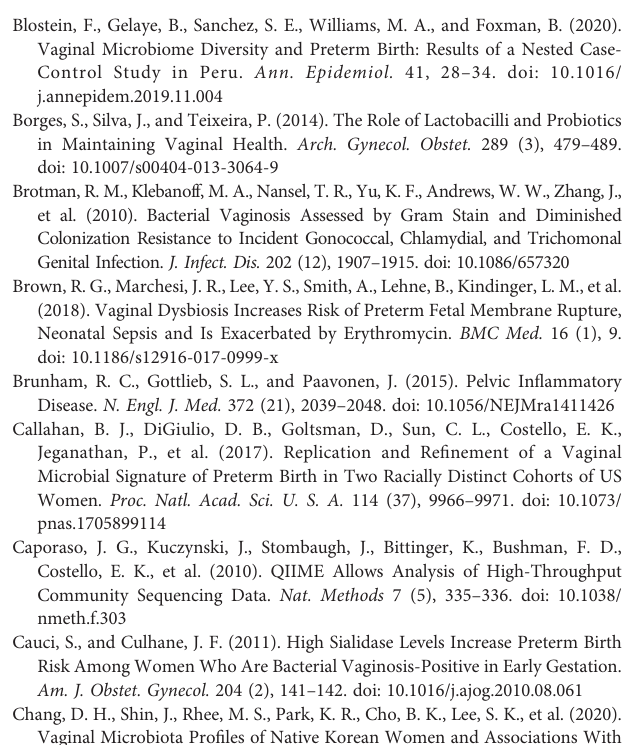
Supplementary Figure 1 | Diversity measures in subjects with non- Lactobacillus dominated microbiota and with Lactobacillus dominated microbiota. (A) Alpha diversity represented by PD-whole-tree and Shannon diversity index in subjects with NLDM and LDM. Boxes with inside line represented interquartile range (IQR) and median, whiskers represented values within 1.5 × IQR of the fi rst and third quartiles, points represented individual subjects. P was calculatedby Wilcoxon test. (B) Principal coordinate analysis (PCoA) based on weighted UniFrac distances between the subjects with NLDM and LDM. Points represented individual subjects, and ellipses represented 95% con fi dence intervals around the cluster centroid. ANOSIM calculated R and P to determine the signi fi cance of clustering. Green indicated NLDM, orange indicated